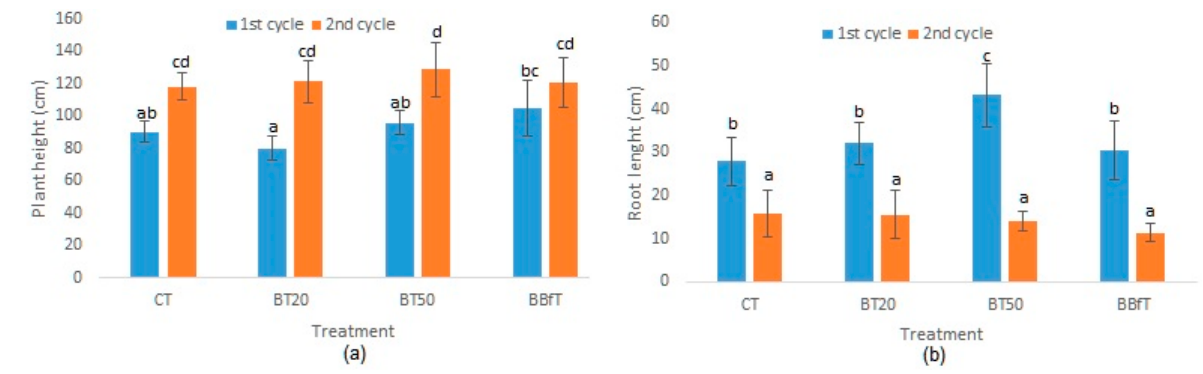
Figure 6. ( a ) Plant height and ( b ) root length of Physalis ixocarpa with different treatments: CT: soil + 100% of chemical fertilization, BT20 and BT50: soil + biochar +, 20, or 50% of chemical fertilization, respectively, and BBfT: soil + biochar + biofertilization. Different letters indicate significant difference ( p < 0.05, Duncan test).